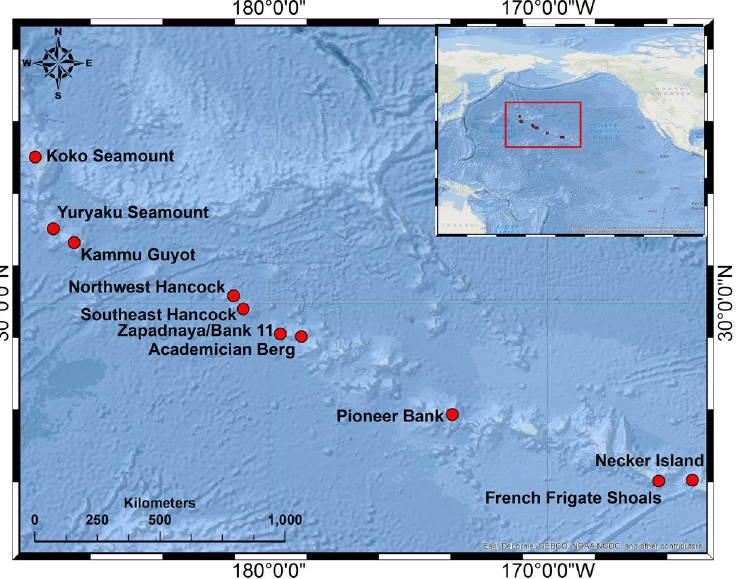
Figure 1. Map showing the geographic locations of surveyed sites. Figure created using ArcMap 10.4.1 with basemap provided by ESRI.